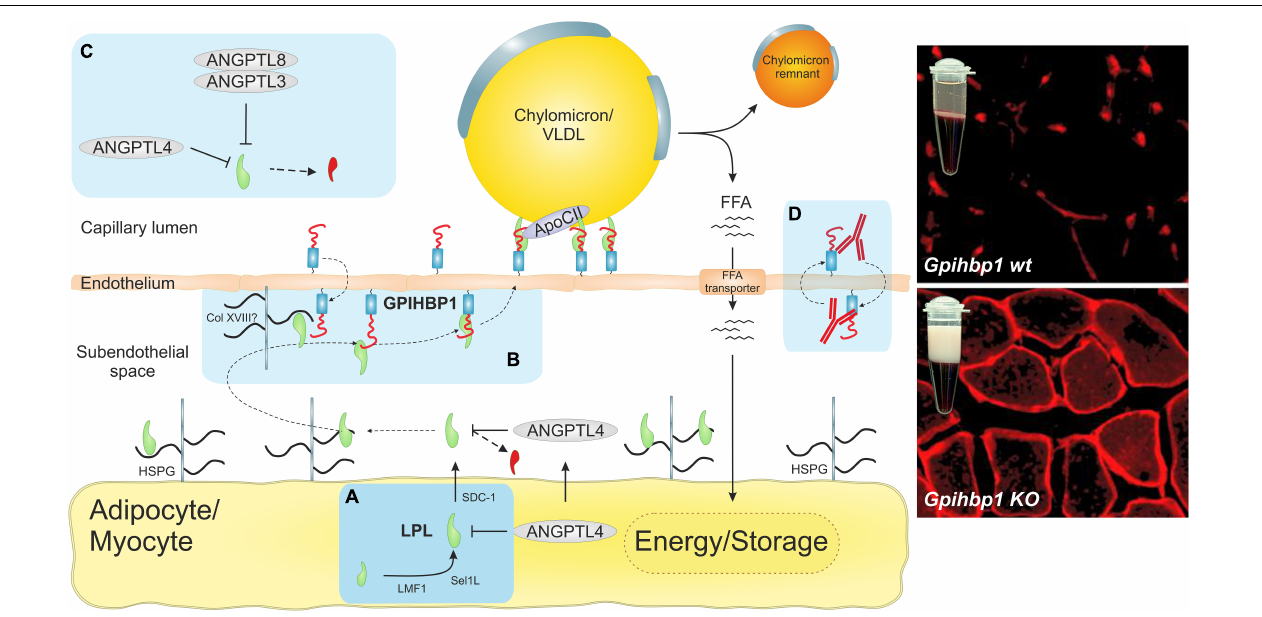
FIGURE 1 | The intravascular unit supports focal triglyceride hydrolysis in capillaries. The light blue boxes highlight recent discoveries concerning LPL-mediated triglyceride hydrolysis in capillaries. (A) Recent data suggested that LPL is synthesized and secreted as a monomer rather that the widely assumed head-to-tail homodimer (Beigneux et al., 2019; Kristensen et al., 2020a). Because LPL is inherently unstable (Leth-Espensen et al., 2021), it must be chaperoned in all compartments to maintain its native fold. During biosynthesis by parenchymal cells, LPL is chaperoned in the ER by lipase maturation factor 1 (LMF1) and Sel-1 suppressor of Lin-12-like 1 (Sel1L). In the secretory pathway after transit from the trans -Golgi network, LPL is chaperoned by heparan sulfate–modified syndecan-1 (SDC1) (Sundberg et al., 2019). In the subendothelial space, LPL is stabilized by heparan sulfate proteoglycans (HSPGs) in the extracellular matrix and in the glycocalyx of parenchymal cells. (B) The seminal discovery that GPIHBP1 shuttles LPL from the abluminal endothelial surface to its site of action in the capillary lumen (Beigneux et al., 2007; Davies et al., 2010; Goulbourne et al., 2014) solved a longstanding enigma (Young et al., 2019). The immunofluorescence micrographs show that LPL ( red ) is localized within capillaries in wild-type mice, but remains mislocalized in the subendothelial space of GPIHBP1-deficient mice, which develop severe chylomicronemia with creamy TRL-rich plasma. GPIHBP1 is organized as a functional dipole with an N-terminal intrinsically disordered acidic domain, which is tethered to a folded disulfide-rich LU domain that harbors a C-terminal glycolipid anchor (Fong et al., 2016; Mysling et al., 2016a). This unique architecture renders GPIHBP1 an efficient chaperone for LPL, stabilizing its native and active conformation (Mysling et al., 2016a). The acidic domain increases the association rate of GPIHBP1 and LPL by 2500-fold, which enables the transition of LPL from an HSPG-bound state to a GPIHBP1-bound state and its subsequent transcytosis to the capillary lumen (Kristensen et al., 2018). (C) Inhibition of LPL activity by ANGPTL-3, -4, and -8 was widely assumed to work by converting stable LPL dimers to unstable monomers. HDX-MS studies showed that ANGPTL4 catalyzes the irreversible unfolding of LPL’s α / β -hydrolase domain by directly targeting LPL monomers (Mysling et al., 2016b; Kristensen et al., 2020a,b; Leth-Espensen et al., 2021). Importantly, GPIHBP1 binding counteracts this inhibition of LPL. A oligomeric complex of ANGPTL3 and ANGPTL8 helps regulate LPL activity in oxidative tissues (Chi et al., 2017; Gusarova et al., 2017; Haller et al., 2017; Kovrov et al., 2019; Chen et al., 2020; Oldoni et al., 2020). (D) The discovery of inhibitory GPIHBP1 autoantibodies revealed a new etiology of acquired hypertriglyceridemia in some patients without any documented mutations in LPL , GPIHBP1 , APOC2 , APOA5 , or LMF1 (Beigneux et al., 2017; Lutz et al., 2020; Miyashita et al., 2020). The immunofluorescence micrographs were modified and reproduced with permission (Davies et al.,